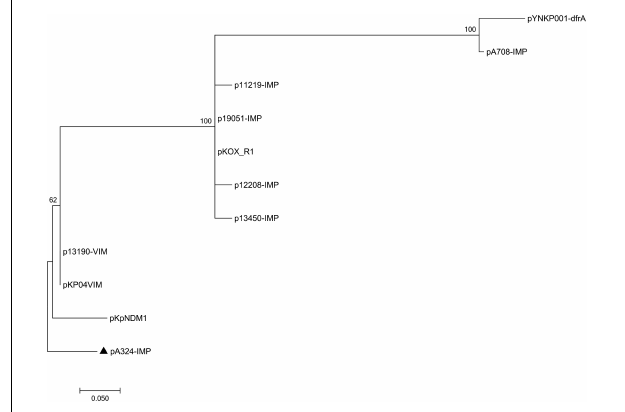
FIGURE 1 | Maximum-likelihood tree. The degree of support (percentage) for each cluster of associated taxa, as determined by bootstrap analysis, is shown next to each branch. The bar corresponds to the scale of sequence divergence. The triangle indicates IncHI5 reference plasmid